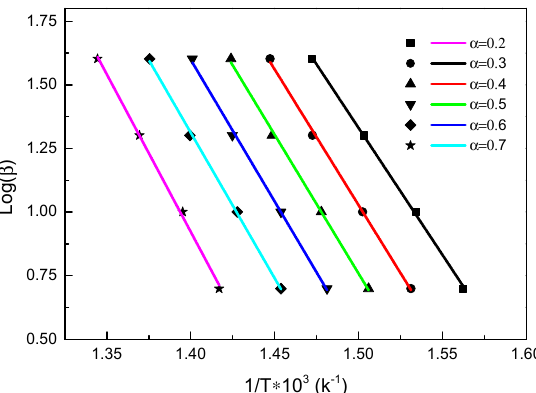
Figure 7. Plots of log β -1/ T by the Ozawa method under inert atmosphere.